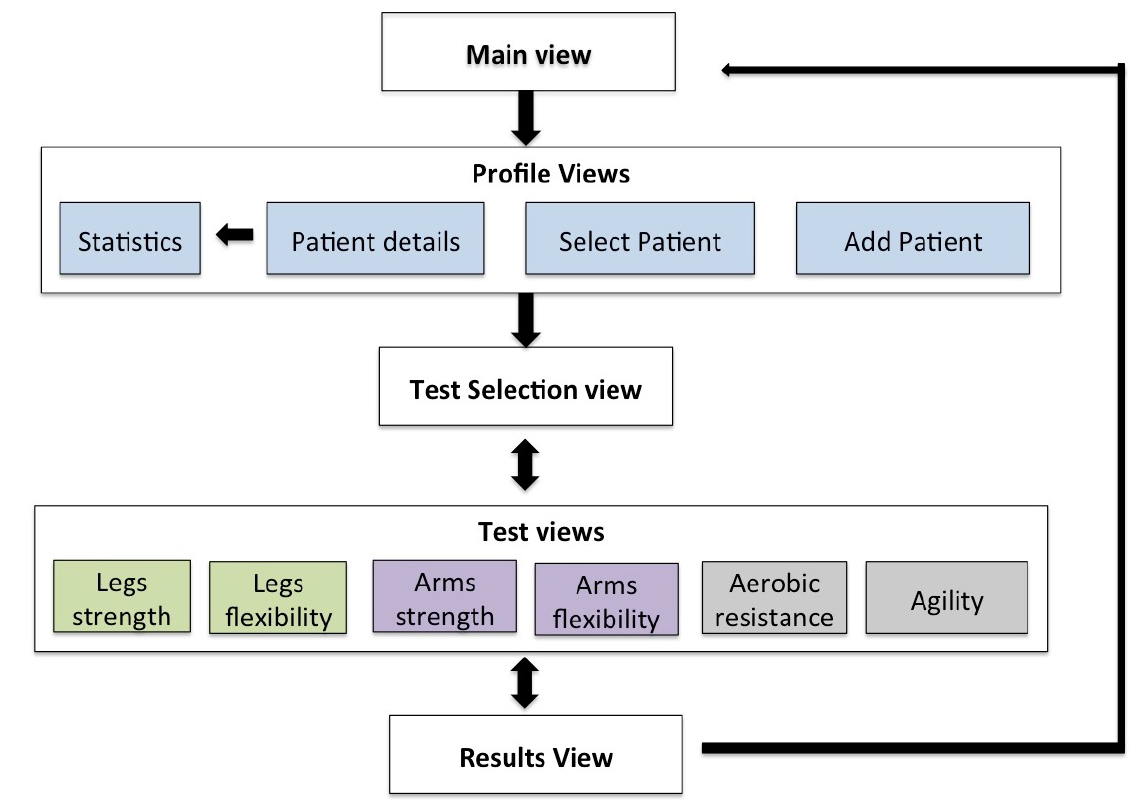
Figure 7. Mobile Senior Fitness Test (m-SFT) views flow.